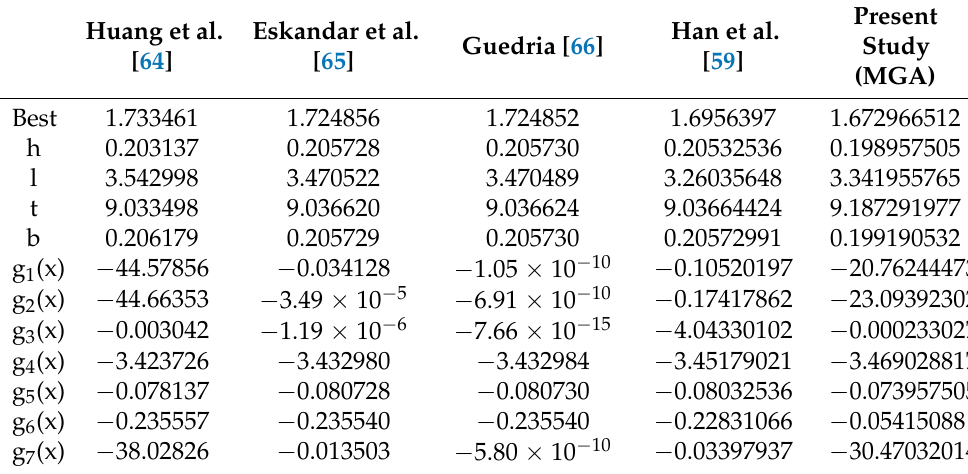
Table A7. Comparison of the best solutions for the welded beam design problem.